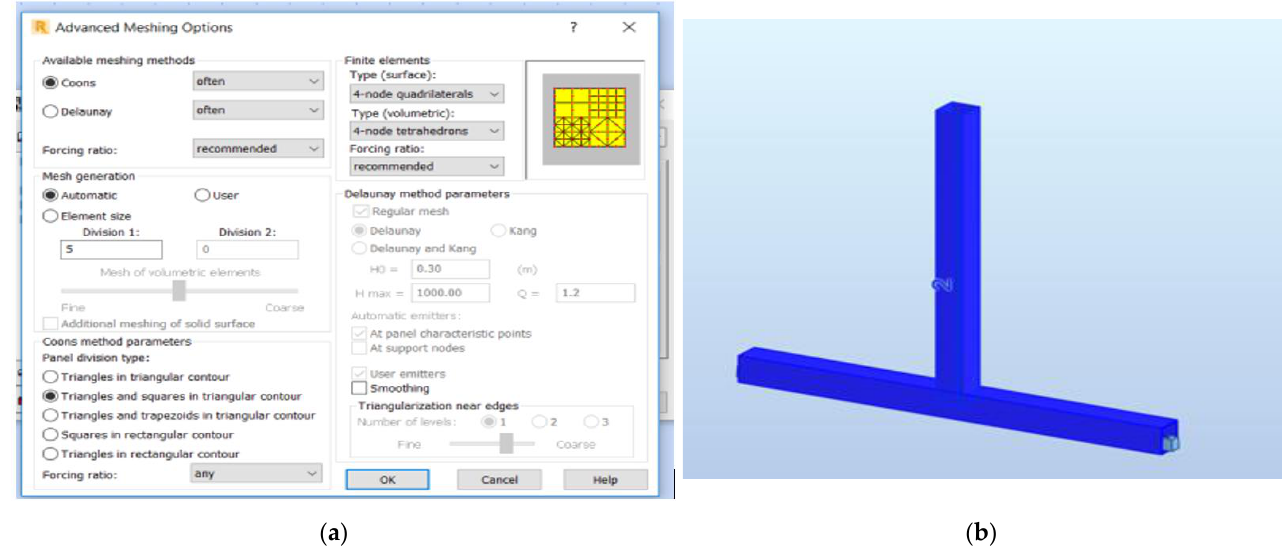
Figure 18. Details of the FEA meshing. ( a ) Meshing data; ( b ) meshing of GFRP beam-column in RSA.